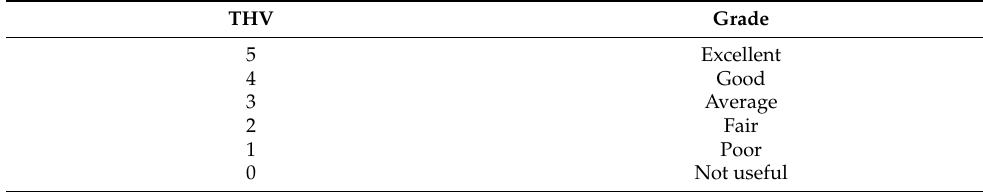
Table 5. Total Hand Values (THVs) for